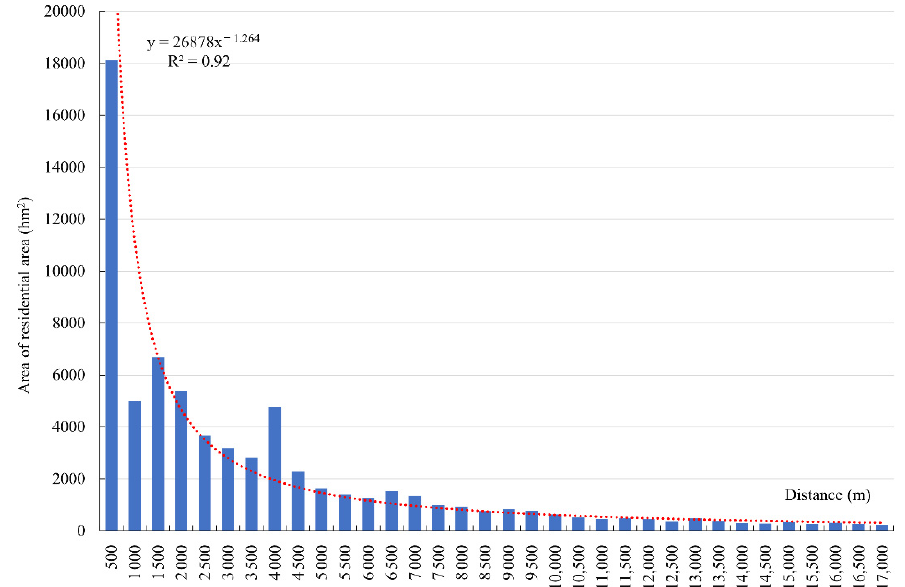
Figure 12. Figure of the total area of residential patch changing with the distance from the road network.